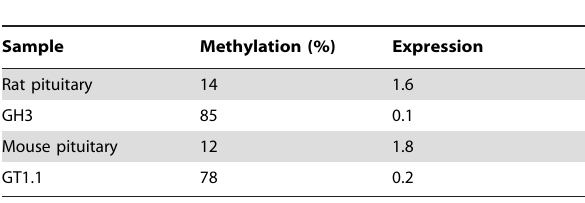
Table 1. Methylation and expression of RASSF3 in rat and mouse normal pituitary samples and somatotroph adenoma cell